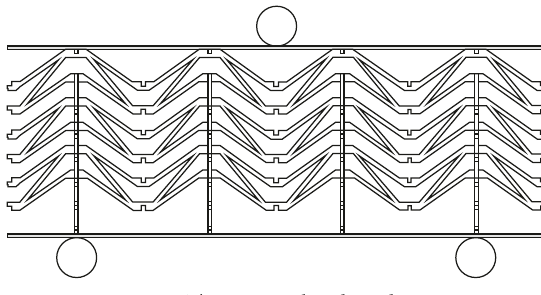
Figure 7: Three-point bending